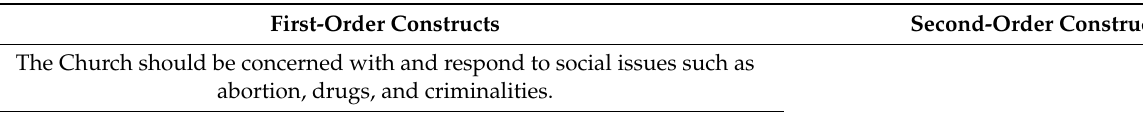
Table 2. For you, what is the mission of the